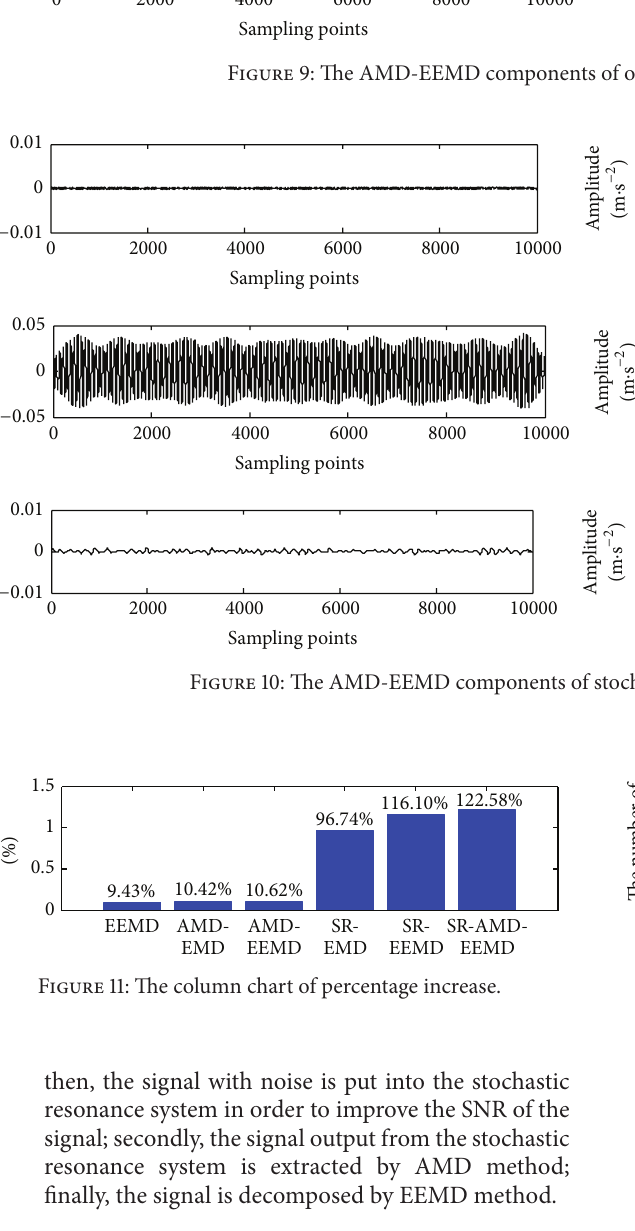
(2) By processing the simulation signal and applica- tion examples and comparing the SR-AMD-EEMD method and EMD, EEMD, SR-EMD, SR-EEMD, AMD-EMD, and AMD-EEMD method,